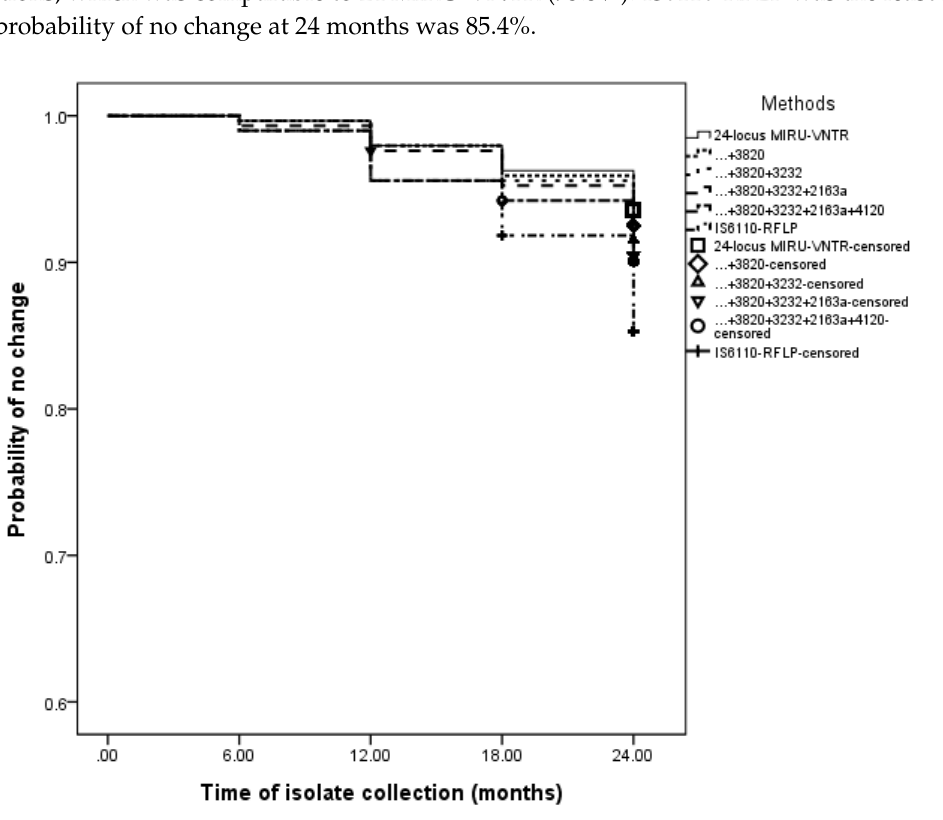
Figure 2. Evaluation of stability in different genotyping strategies applied on 294 randomly selected isolates.